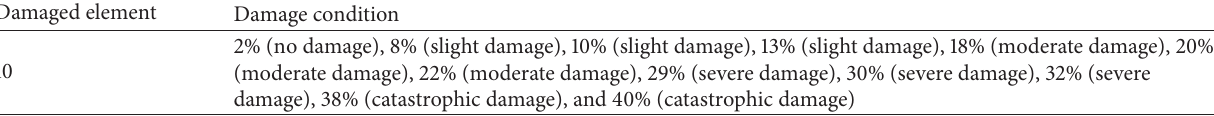
Table 6: Test samples for fuzzy system of damage condition assessment with single location. Damaged element